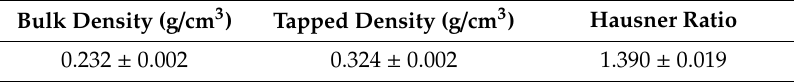
Table 1. Densities and Hausner ratio of UHMWPE